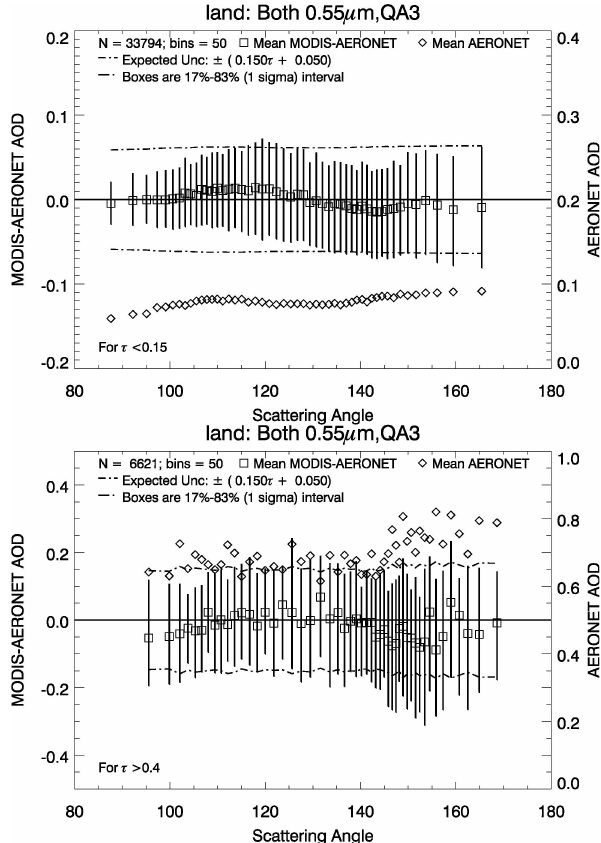
Fig. 12. Differences between MODIS and AERONET-reported AOD at 0.55µm (MODIS-AERONET) vs. MODIS-observed scat- tering angle, for QAC=3, for the “light” ( τ < 0 . 15; top) and “heavy” ( τ > 0 . 4; bottom) aerosol loading cases. The explanation of symbols is given in Fig.